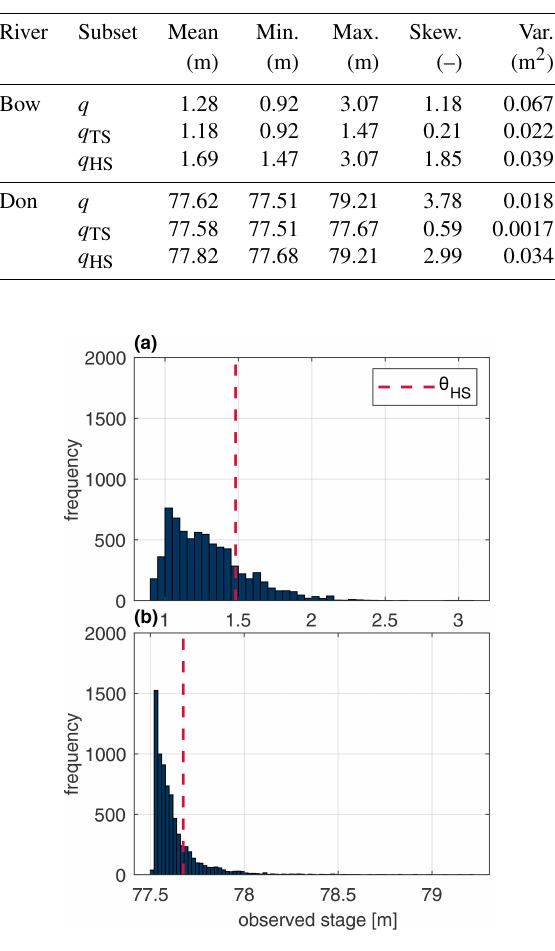
Figure 2. Histograms of the observed stage for the (a) Bow River 6h stage and (b) Don River hourly stage. The dashed red line in- dicates the fixed threshold used to distinguish between typical and high stage